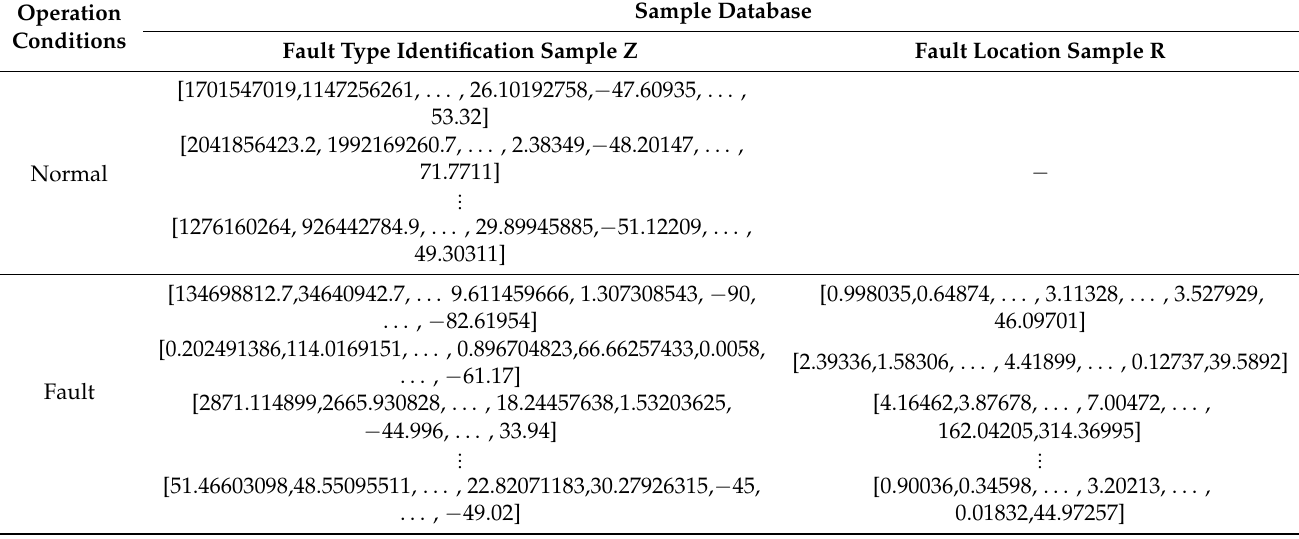
Table 4. Sample volume and code of cable fault locations. Table 3. Sample volume and code of cable fault types. Table 3. Sample volume and code of cable fault